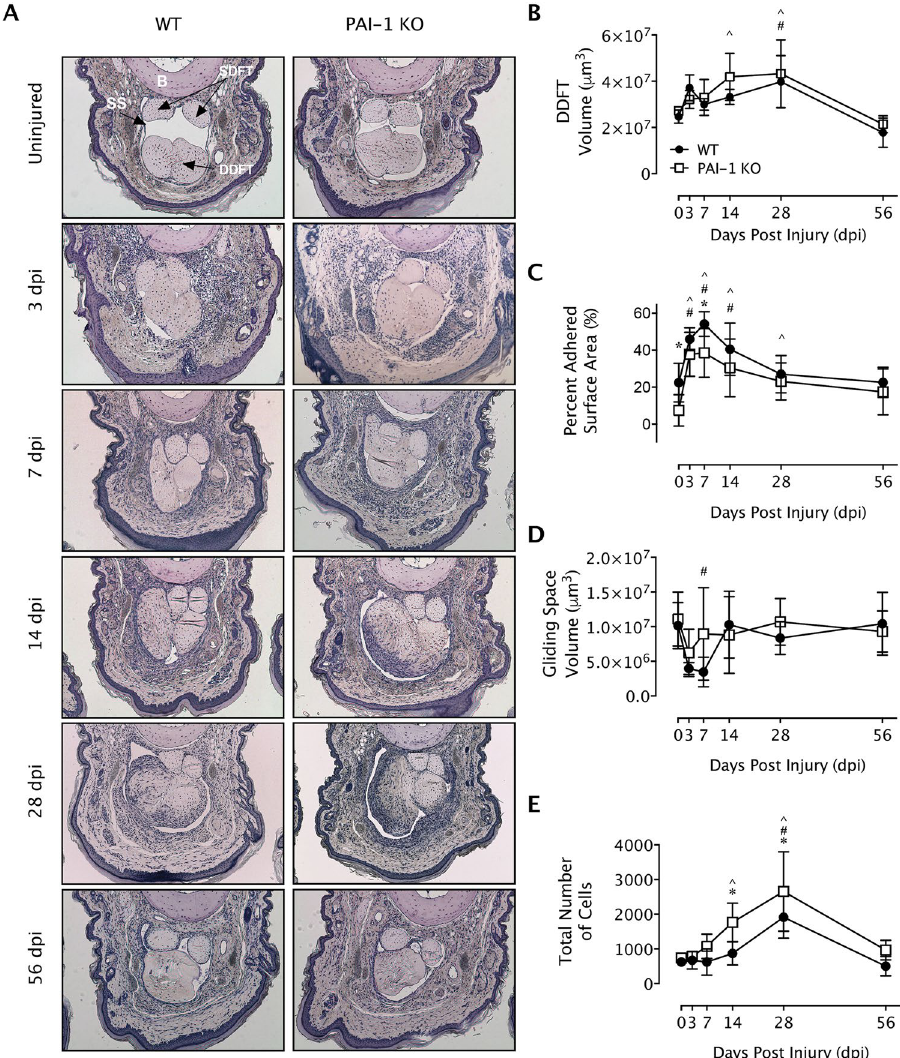
Figure 3. Loss of PAI-1 significantly decreased the adhesion of flexor tendons to subcutaneous tissue at early time points following flexor tendon injury in zone II of the mouse hind paw. ( A ) Representative micrographs of hematoxylin-stained cross-sections of the digits of WT (C57Bl/6 J) and PAI-1 KO mice before and after zone II injury up to 8 weeks post injury. All representative micrographs represent the third out of five levels analyzed, corresponding to the center of the region of interest. Qualitatively, thickening of the synovial sheath and increased peritendinous cellular activity (indicated by intense hematoxylin staining) were observed at early time points with manifest adhesions peaking around 7 dpi. The deep digital flexor tendons of WT and PAI-1 KO mice became highly cellular by 14 days and progressively remodeled overtime thereafter. ( B ) Histomorphometric quantification of tendon cross section area, averaged over the five levels, shows no significant differences between WT and PAI-1 KO mice. ( C ) The length of tendon perimeter adhered to the subcutaneous tissue was assessed for each of the five levels, and the total surface area of tendon adhered to the subcutaneous tissue was determined by integrating the length of adhered tendon over the five levels. The percentage of the tendon surface area adhered to subcutaneous tissues was then quantified and demonstrated significantly reduced adhesions in the PAI-1 KO mice compared to WT mice at 3 and 7 dpi. ( D ) The total volume of the sheath space around the flexor tendons, calculated by integrating the sheath space areal measurements from the five levels, significantly decreased between 3 and 7 dpi in both WT and PAI-1 KO mice. ( E ) Cells within the uninjured and injured tendons were counted in DAPI-stained sections from all five levels. Total cell counts significantly increased over time in both WT and PAI-KO mice peaking by 28 dpi. However, total cell counts in the PAI-1 KO tendons were significantly greater than the WT at 14 and 28 dpi. Data in B–E are expressed as mean ± standard deviation (SD). Asterisks ( * ) indicate significant differences between WT and PAI-1 KO (p < 0.05). Pound symbols ( # ) indicate significant differences between uninjured and injured in WT (p < 0.05). Caret symbols (^) indicate significant differences between uninjured and injured in PAI-1 KO (p < 0.05). B = proximal phalanx bone, SS = synovial sheath, SDFT = superficial digital flexor tendon, DDFT = deep digital flexor tendon, SCT = subcutaneous